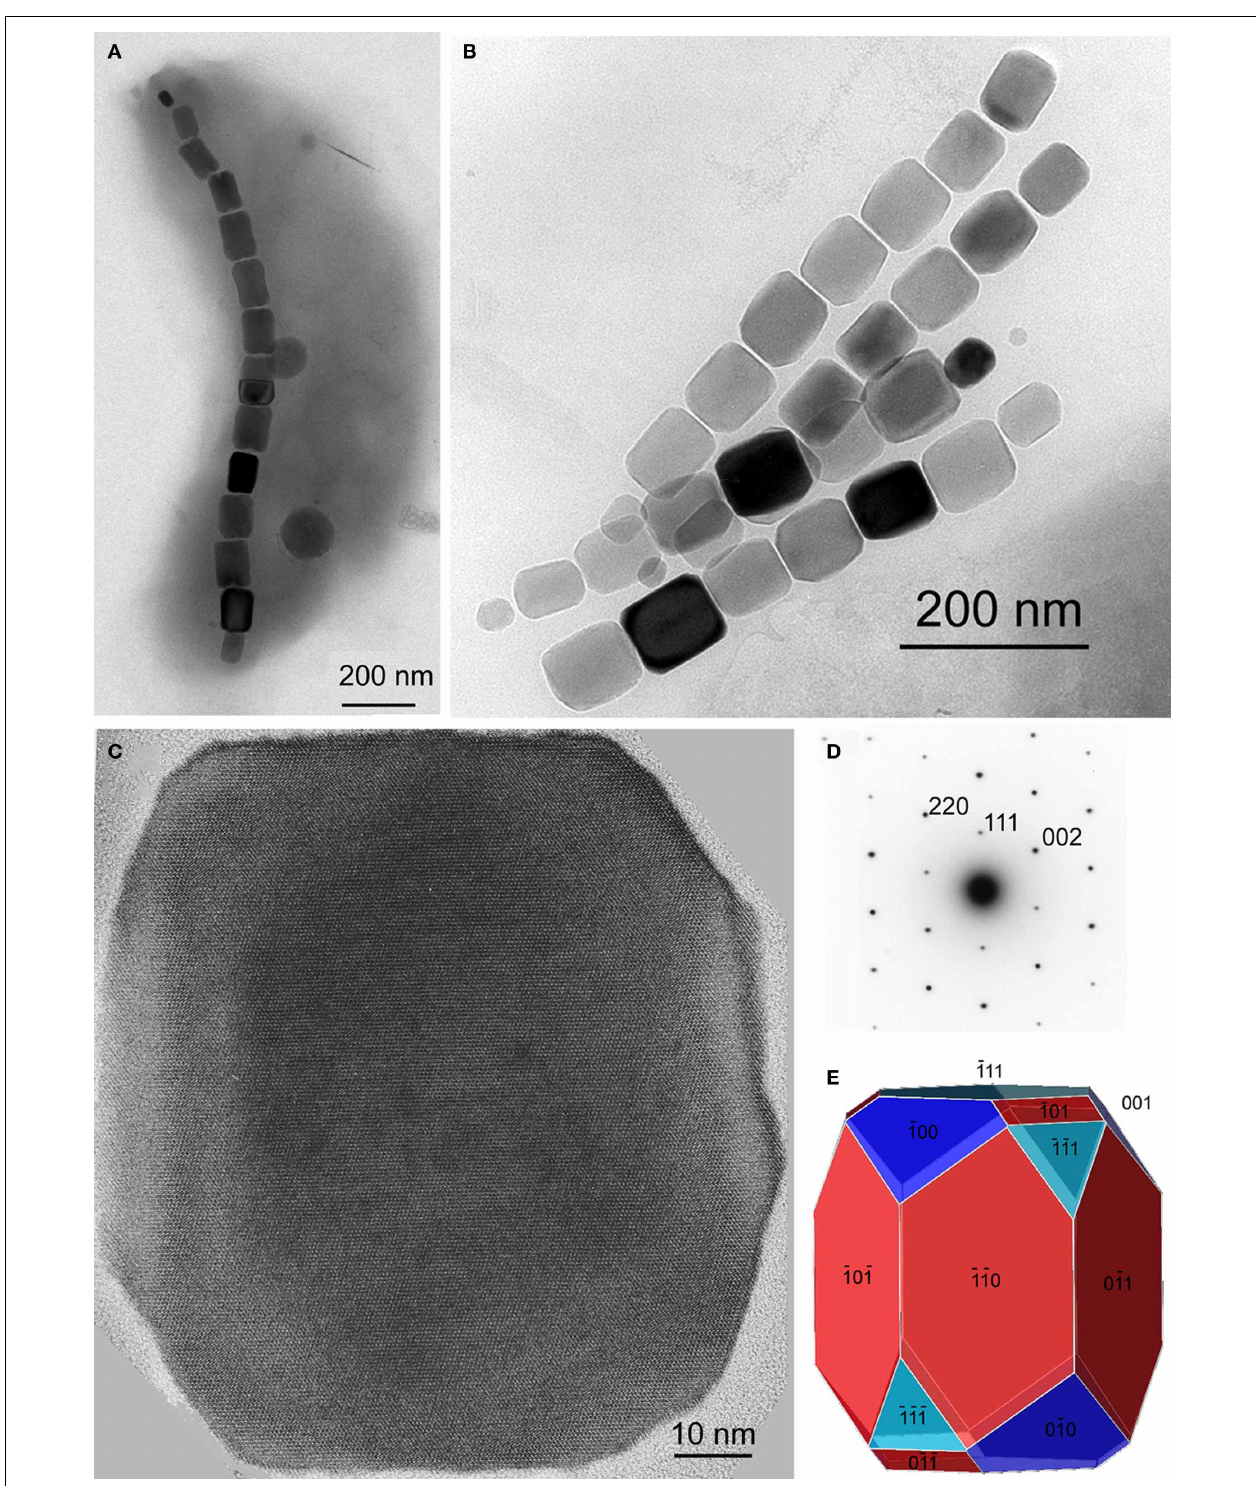
FIGURE 3 | Magnetite magnetosomes with elongated prismatic habits from magnetotactic Alphaproteobacteria . (A) TEM image of a cell of a vibrioid MTB from Lake Mead, Nevada, containing a chain of elongated magnetosomes. (B) TEM image of two double chains of elongated magnetosomes from a freshwater coccus. (C) High-resolution